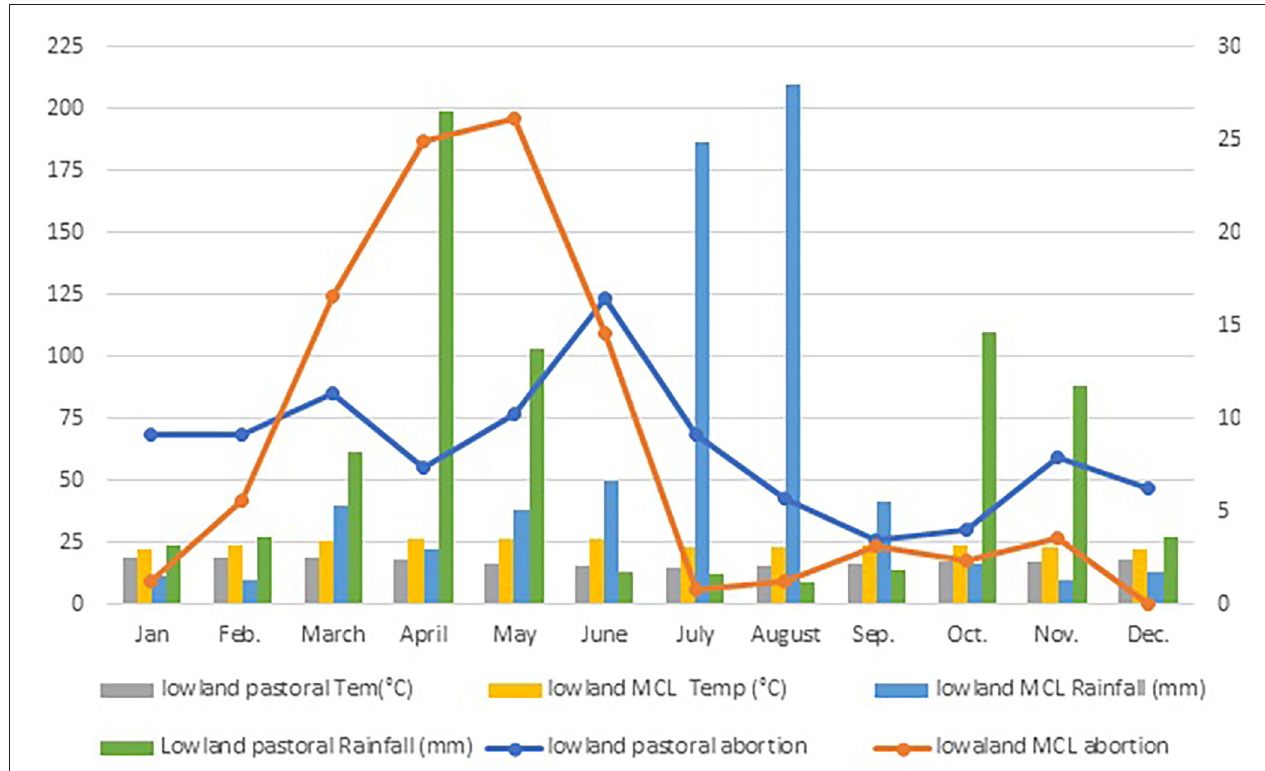
FIGURE 5 | Monthly levels of sheep and goat abortion in comparison with mean monthly temperature and rainfall distribution for lowland MCL and pastoral agroecology and production system.